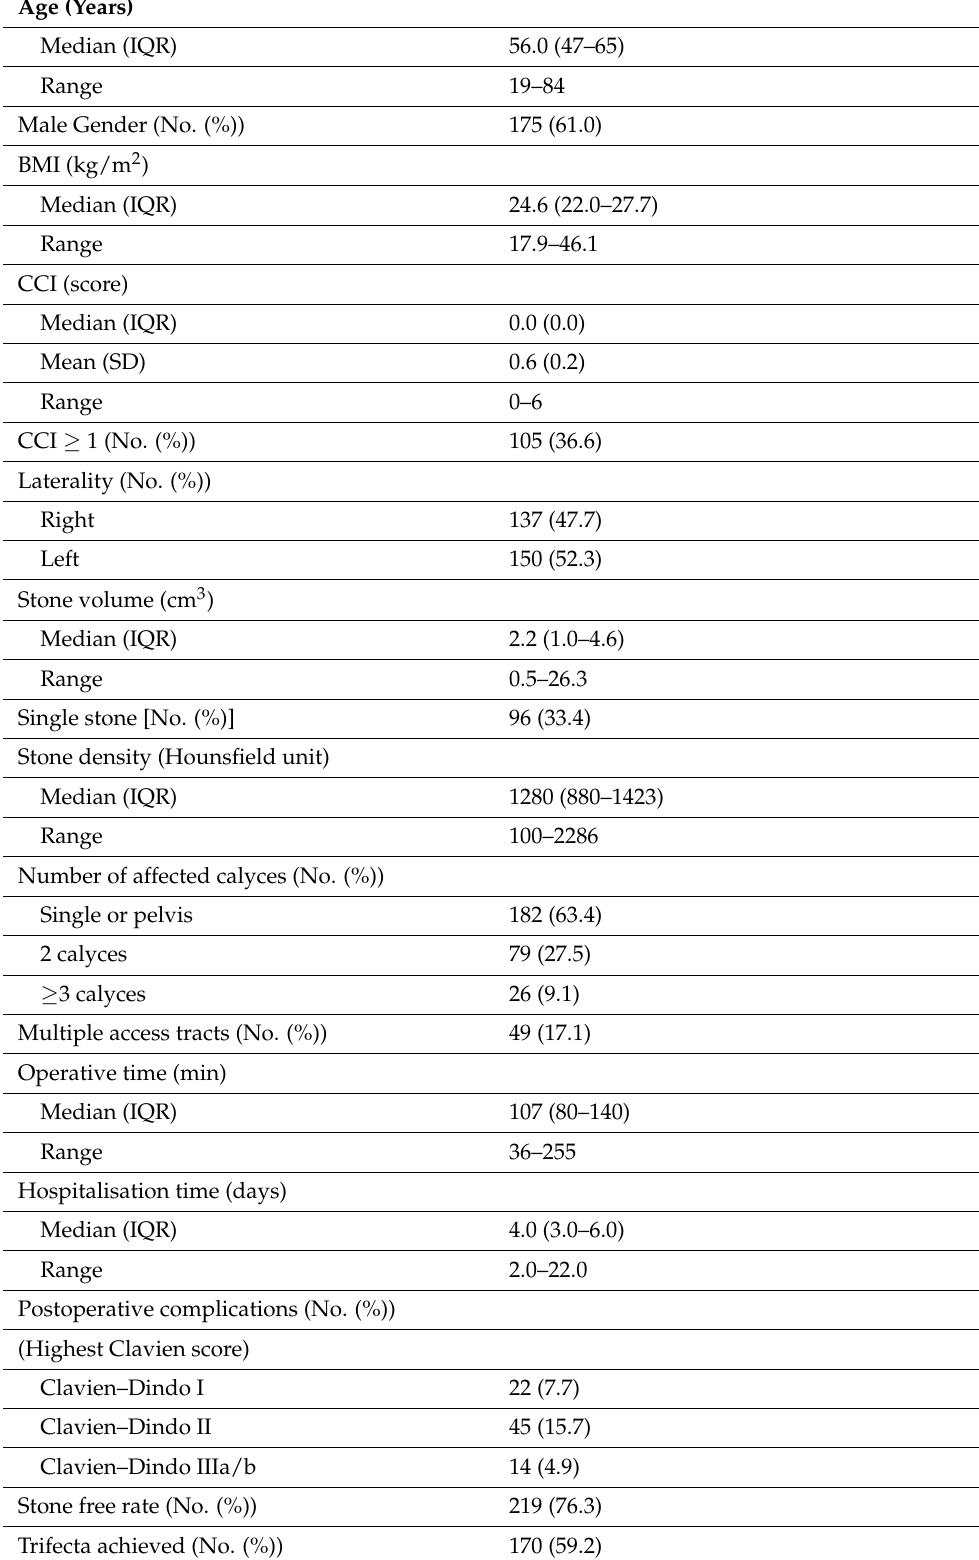
Table 1. Demographic characteristics of the whole cohort ( n =